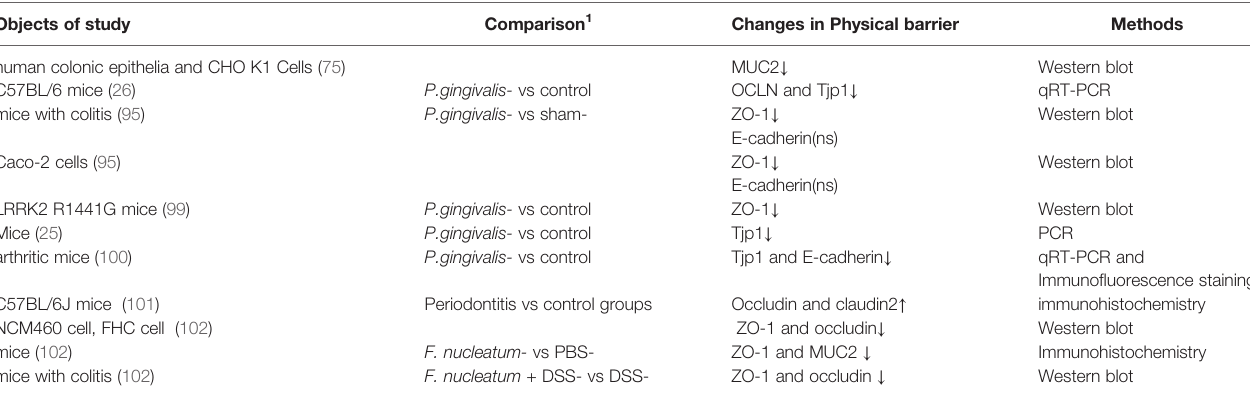
TABLE 2 | Main studies about the effects of periodontal pathogens on the intestinal physical